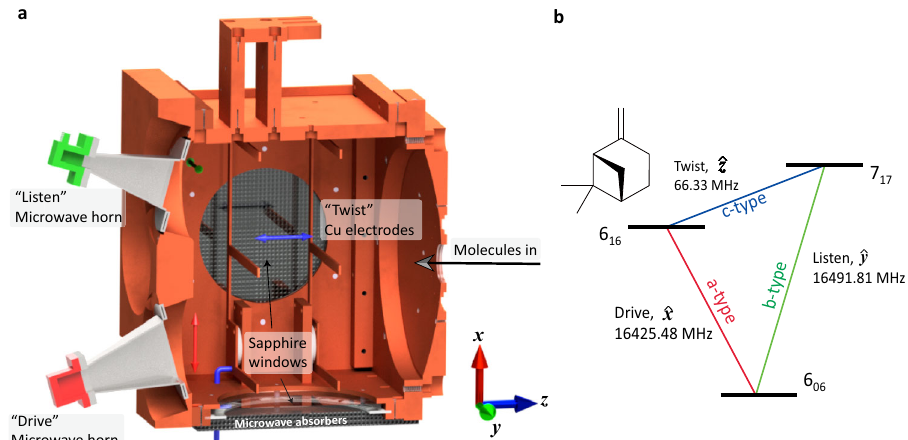
Fig. 1 Three-wave mixing spectra in a buffer gas cell. a Cut-away of the buffer gas cell used for acquiring three-wave mixing spectra. Arrows colored in red, blue, and green indicate the polarization of the drive, twist, and listen pulses. The back and bottom side of the cell have sapphire windows covered on the outside with microwave absorbers. b A typical M3WM excitation scheme for β -pinene.The three transitions are polarized perpendicular to one another and form a triangle that consists of an a-type, a b-type, and c-type